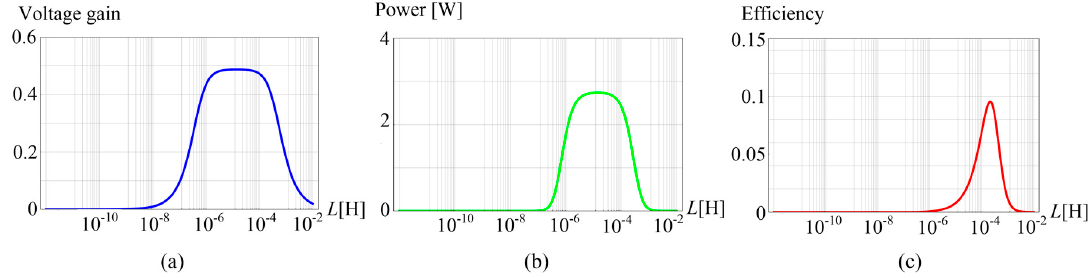
Figure 12. ( a ) Curve chart of voltage gain related to coupler’s windings; ( b ) Curve chart of power related to coupler’s windings; ( c ) Curve chart of efficiency related to coupler’s windings. ( L : self-inductance of windings).